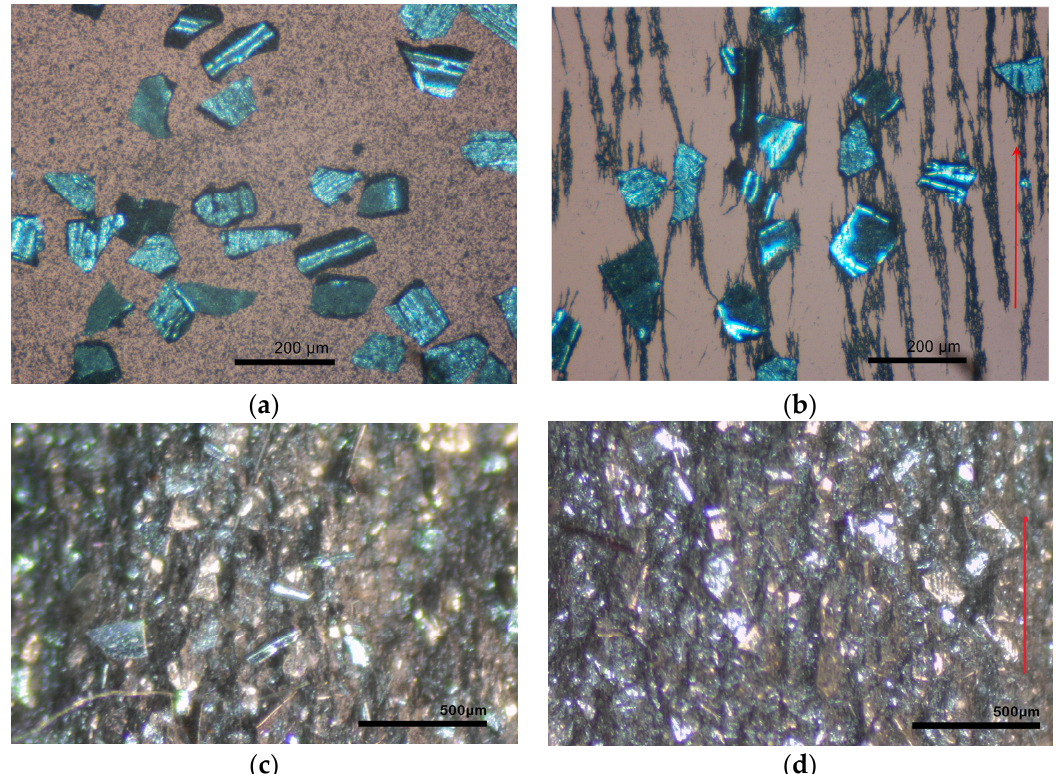
Figure 2. Optical micrographs of a mixture of NdFeB and Fe particles in silicone oil ( a ) in the absence of any magnetic field and ( b ) after the magnetization in the magnetic field of 1T (the red arrow shows the direction of the magnetizing field). Optical micrographs of a section of MAE–Fe sample ( c ) after preparation and ( d ) after magnetization in the magnetic field of 1.5T.